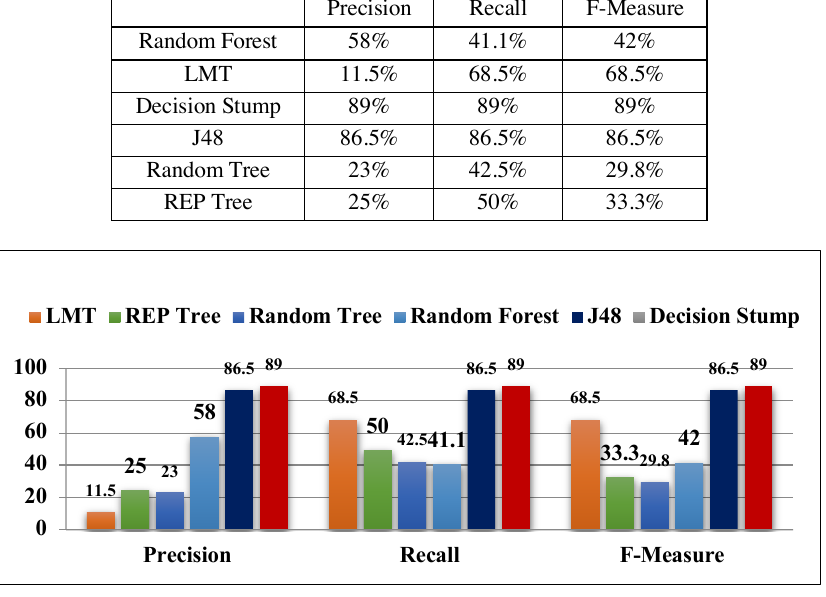
Table 1 . The average precision, recall, and F-measure the score for each decision tree algorithm. Precision Recall F-Measure Random Forest